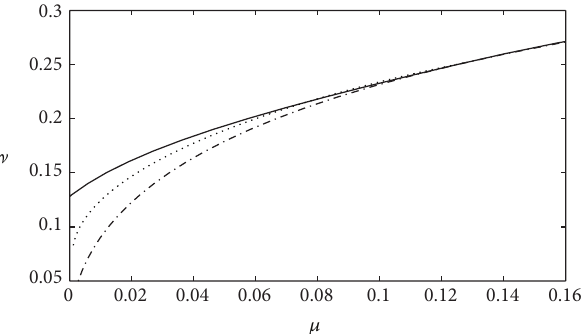
Figure5:Comparisonbetweenthecurveofnonhyperbolicperiodic of (155): the dotted curve was obtained numerically orbits 𝐶 NH with the software MATCONT and the continuous curve from the representation (165). The dot-dashed curve is the Hopf